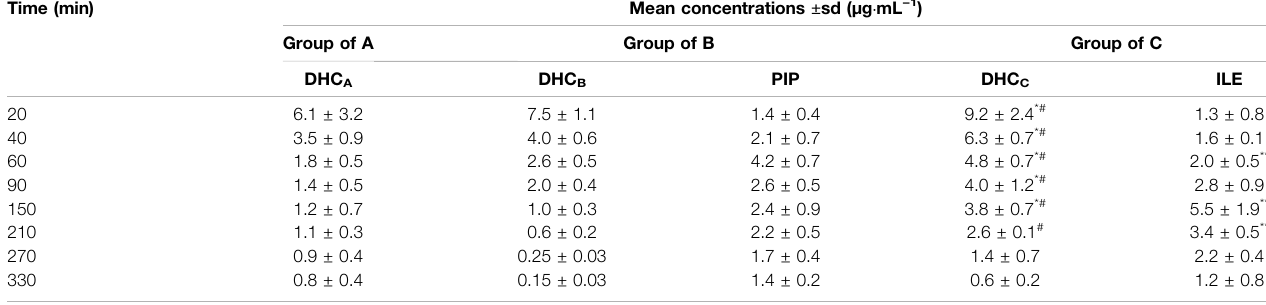
TABLE 4 | Blood concentrations of DHC, PIP and ILE. Time